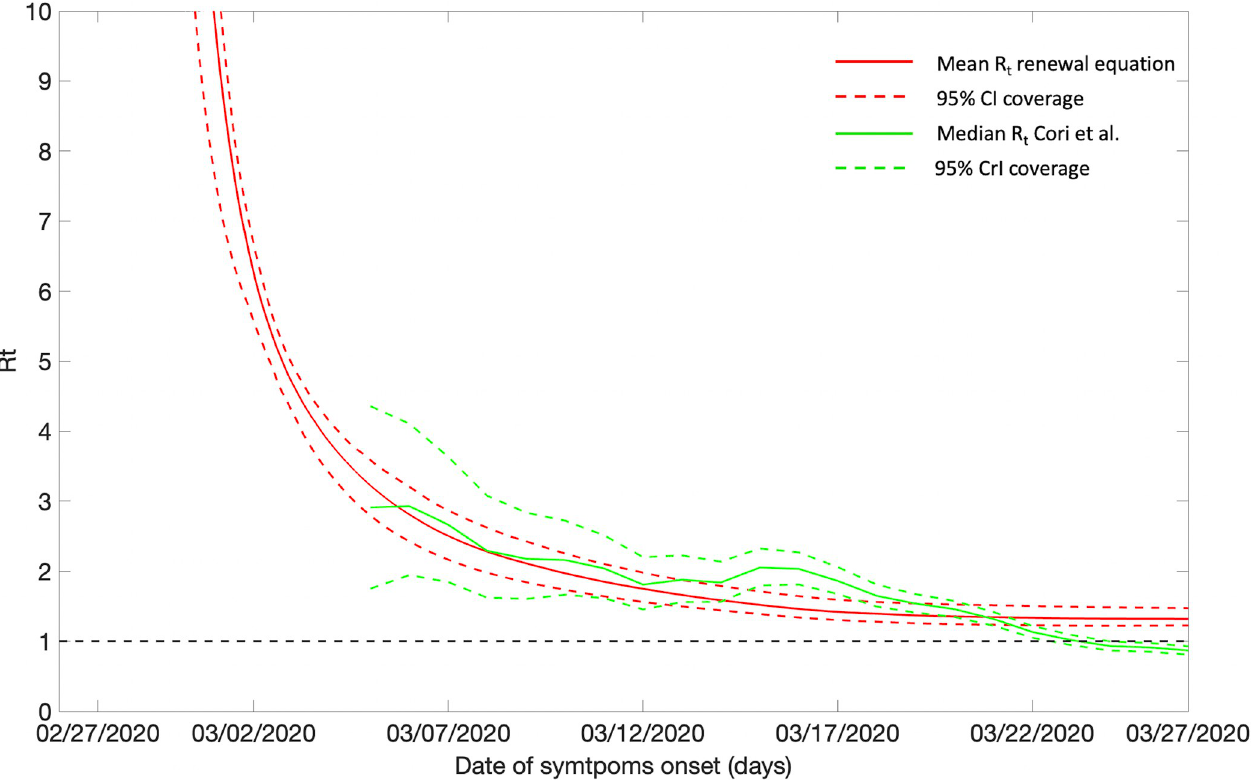
Fig 7. Effective (instantaneous) reproduction number with 95% CrI estimated using the Cori et al. method and the estimate of reproduction number with 95% CI utilizing the GGM for simulating the parameters employed in the renewal equation method for the COVID-19 epidemic in Colombia as of March 27, 2020 (first 30 days). The red solid line is the mean reproduction number estimated from the renewal equation method and the red dashed lines are the 95% CI coverage around the mean reproduction number. The green solid line is the median effective reproduction number estimated from the Cori et al. method and the green dashed lines are the 95% CrI coverage around the median instantaneous